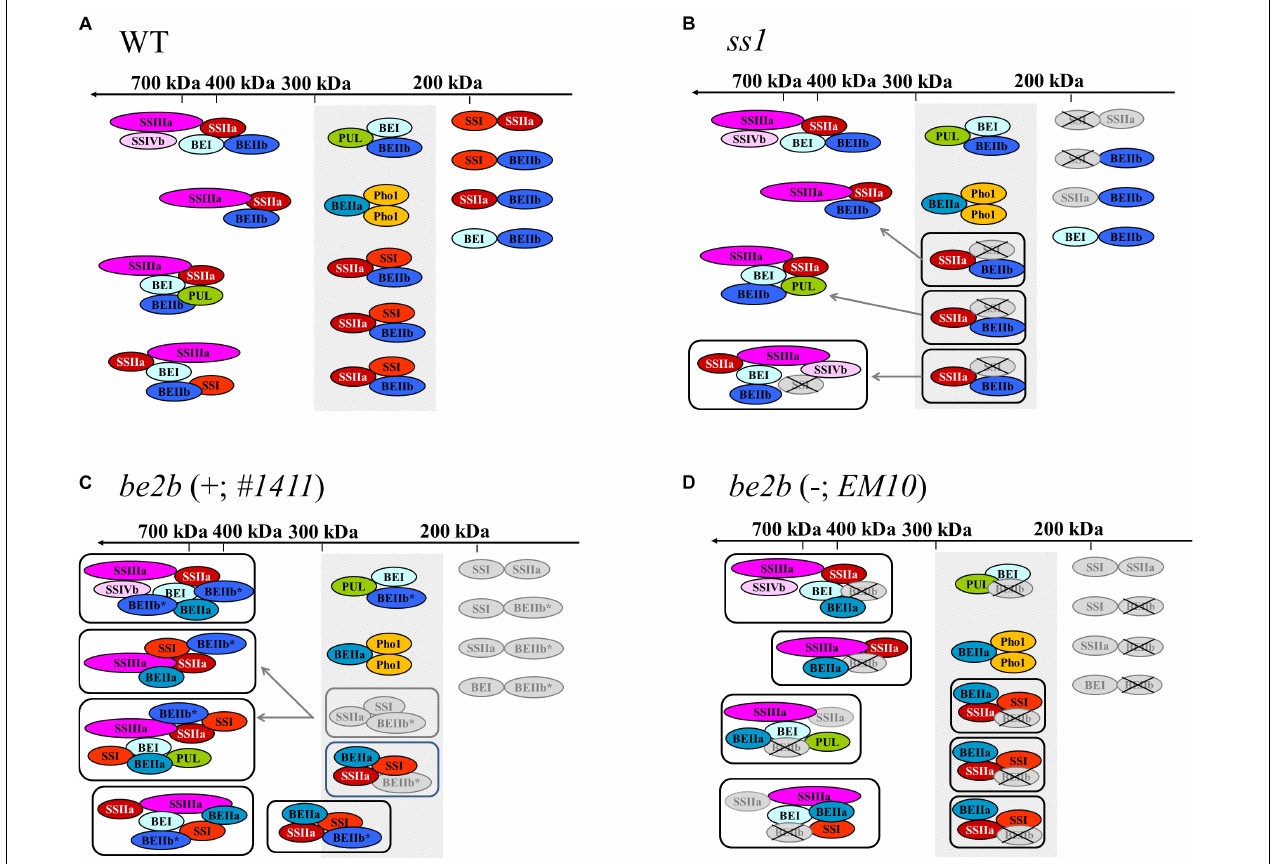
FIGURE 6 | Schematic representation of the proposed starch biosynthetic protein complexes in developing rice seeds. Selected protein complexes expected in the wild-type japonica rice (Crofts et al., 2015; Hayashi et al., 2018) (A) , ss1 mutant (B) , be2b mutant producing inactive BEIIb (C) , and be2b mutant lacking BEIIb protein (D) . The missing isozymes are crossed-out. Boxes indicate altered protein complex formation. Isozymes whose levels are lower than in the wild-type are indicated in gray. Newly recruited isozymes or isozymes whose levels are higher than in the wild-type are indicated by bold ovals. Gray arrows indicate enzyme recruitment. Shaded box in the 200–300-kDa region indicates the molecular weight range in which the SSI–SSIIa–BEIIb trimeric complex elutes in the wild-type. The asterisk indicates inactive BEIIb. Note that the SSIIa activity in all plant lines used in the current study is low because they have been derived from japonica rice (Nakamura et al.,